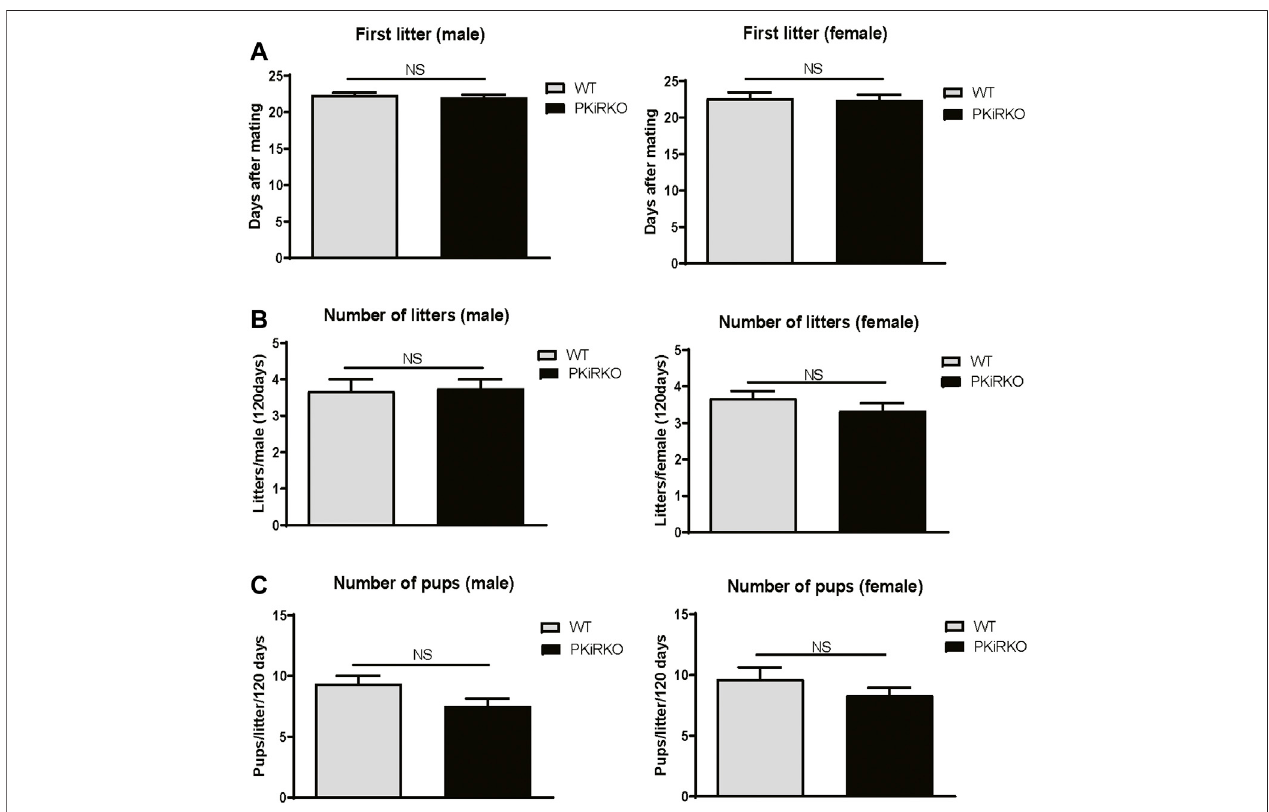
FIGURE4| PKiRKOMiceHaveNormalFertility. (A) AfterintroductionwithWTfemale(leftpanel)ormale(rightpanel)respectively,thedayof fi rstlitterwasrecorded. Values are mean ± S.E.M. NS, no signi fi cant. (B) Total numbers of litters per male (left panel) or female (right panel) was not signi fi cantly different between WT and PKiRKO mice. (C) Number of pups per litter was also not signi fi cantly different between WT and PKiRKO mice (male, left panel; female right panel).